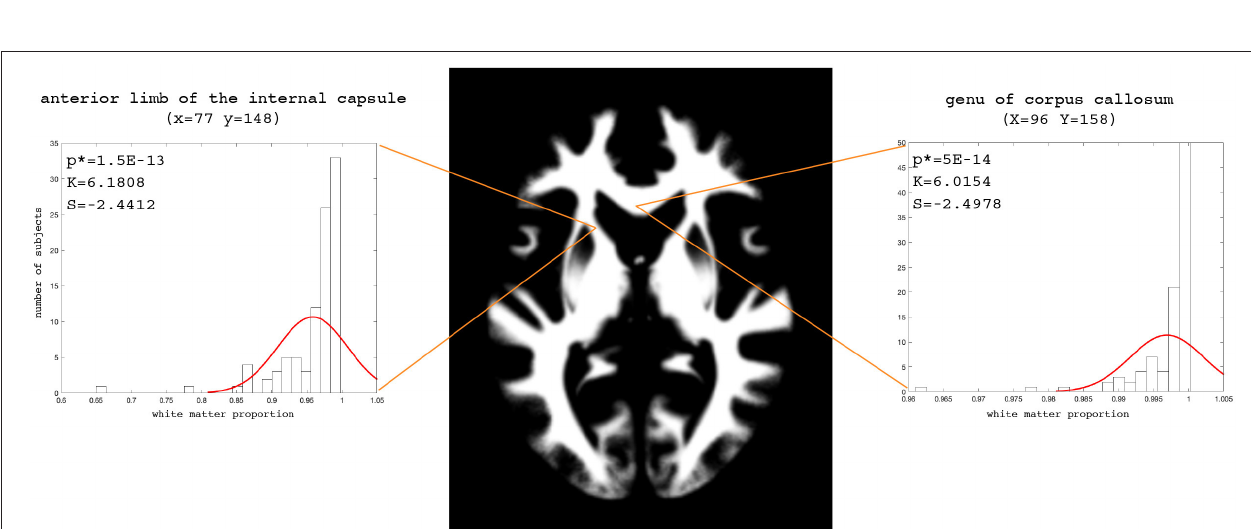
Frontiers in Neuroinformatics |